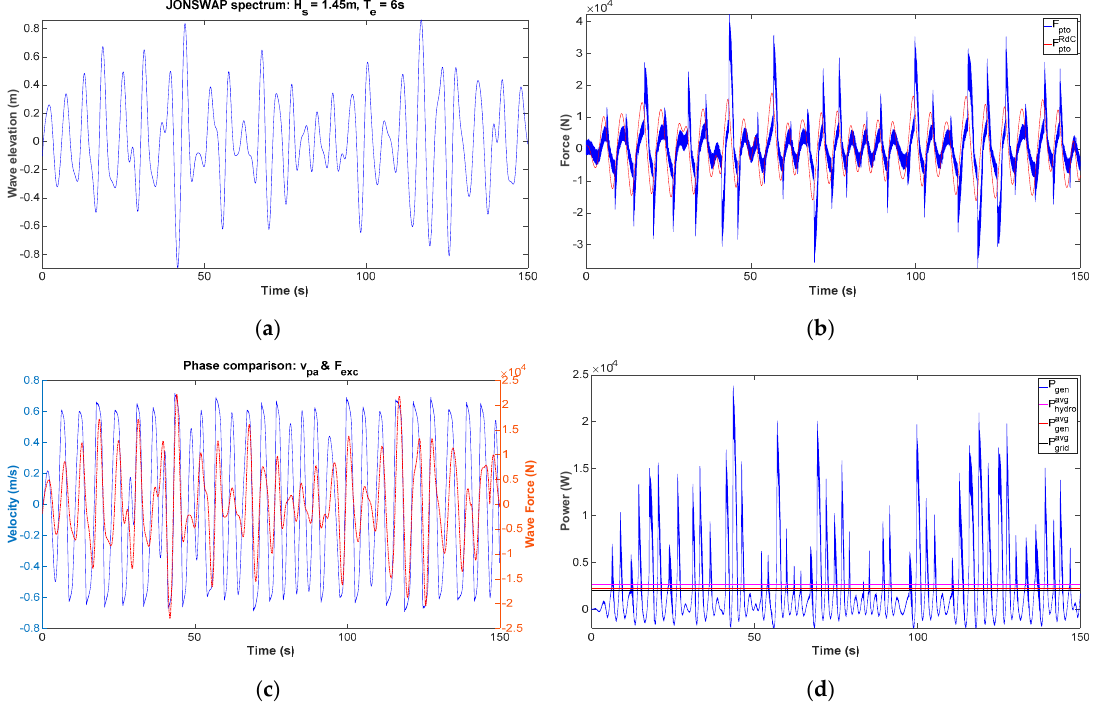
Figure 10. Simulation results using the RsdC method. ( a ) Wave resource used as input; ( b ) Reference and actual PTO force; ( c ) Phase comparison between the velocity and wave excitation force; ( d ) Instantaneous generator power and average hydrodynamic, generator and grid power.